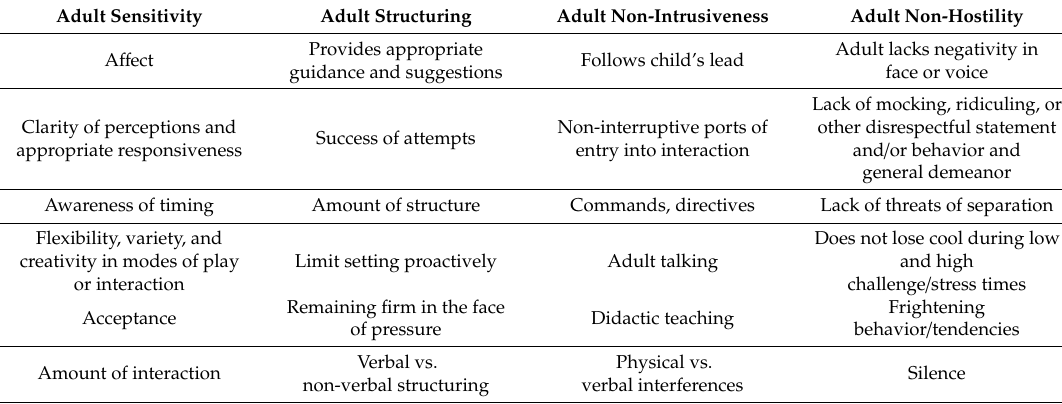
Table 3. Scales and subscales of the Emotional Availability